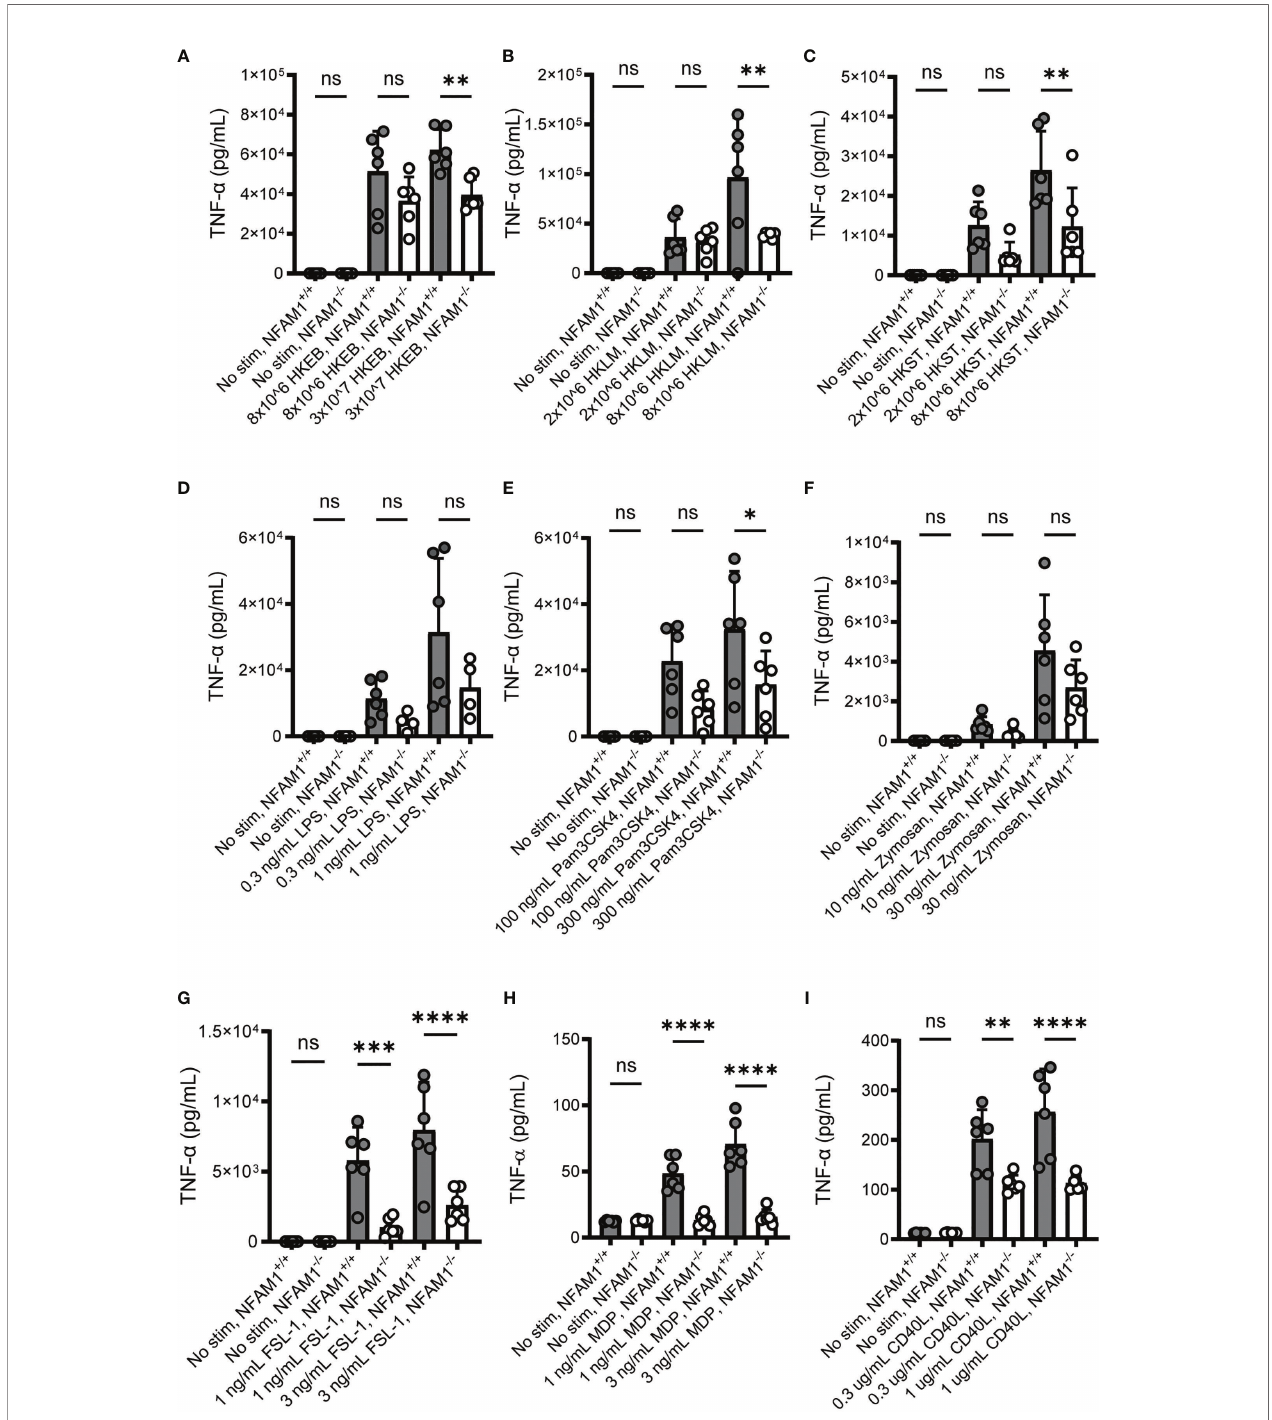
FIGURE 4 | NFAM1 -/- monocytes produce reduced TNF- a in response to activation with multiple IBD-relevant stimuli. Monocytes were isolated from 6 NFAM1 +/+ mice and 6 NFAM1 -/- mice. Monocytes were primed with IFN- g and stimulated with HKEB, HKLM, HKST, LPS, Pam3CSK4, Zymosan, FSL-1, MDP and CD40L for 48 hours. Mean TNF- a production is shown in (A – I) . HKEB, HKLM, HKST, Pam3CSK4 and FSL-1 data are representative of two independent experiments in which NFAM1 -/- monocytes produced reduced TNF- a in response to at least one concentration of each stimuli. LPS and Zymosan data are representative of 3 independent experiments in which there was consistently no statistically signi fi cant difference between TNF- a production in NFAM1 +/+ and NFAM1 -/- monocytes. MDP and CD40L data are representative of 3 independent experiments in which NFAM1 -/- monocytes produced reduced TNF- a in response to multiple concentrations of MDP and CD40L. Statistical signi fi cance is depicted as follows: **** indicates a P value of <0.0001, *** indicates a P value of <0.001, ** indicates a P value of <0.01, * indicates a P value of <0.05 and ns indicates the comparison is not statistically signi fi